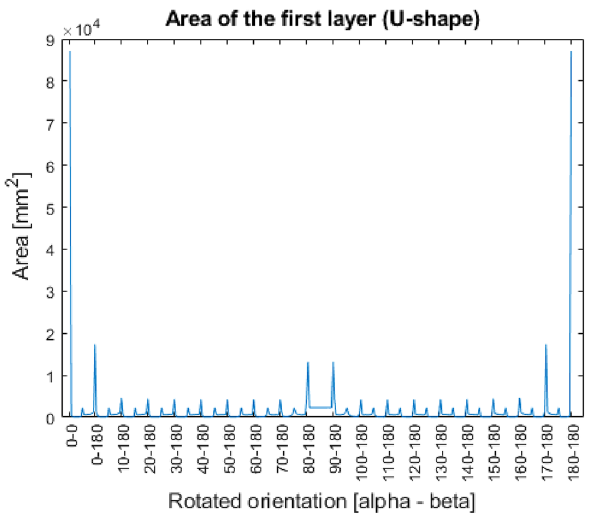
Figure 11. Area of the first layer